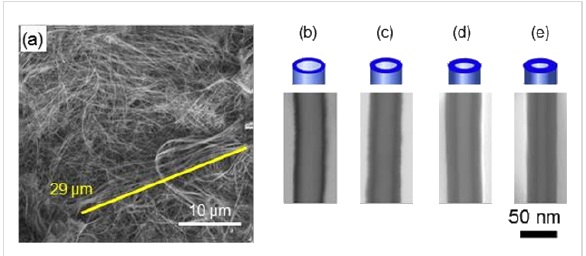
Figure 4: (a) SEM image of a bundle of highly-flexible SiO 2 nanotubes after dissolution of the PC membrane. (b–e) STEM-in-SEM images of representative sections of SiO 2 nanotubes after applying 28, 56, 84, and 112 ALD cycles, respectively.